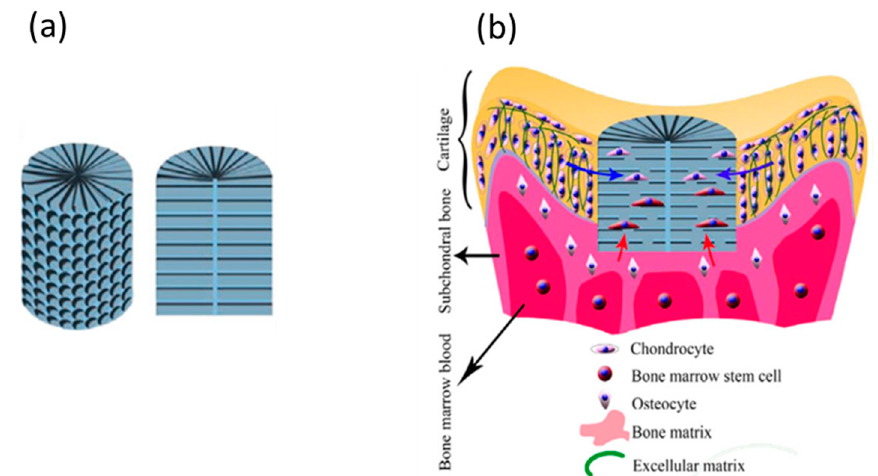
Figure 3. Schematic illustration to show ( a ) the radially oriented pores scaffold, O-PLGA and ( b ) its implantation in an osteochondral defect in a rabbit model. The blue and red arrows in ( b ) refer to the bioactive interflow from neighbor cartilage and subchondral bone layers, respectively. PLGA—poly(lactide-co-glycolide). With permission [48].